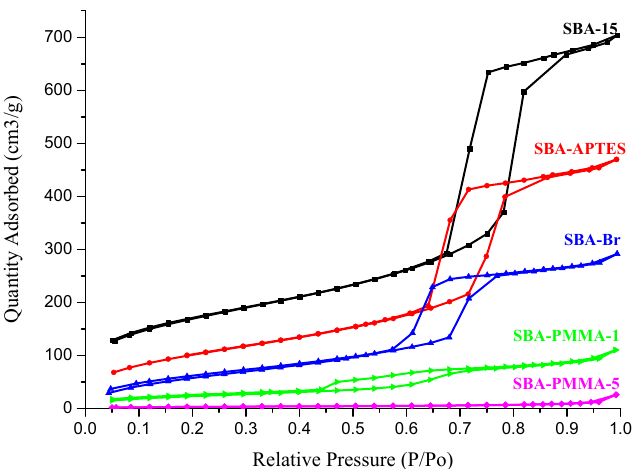
Figure 4. N 2 adsorption-desorption isotherms of SBA-15; SBA-APTES; SBA-Br; SBA-PMMA-1; and SBA-PMMA-5.